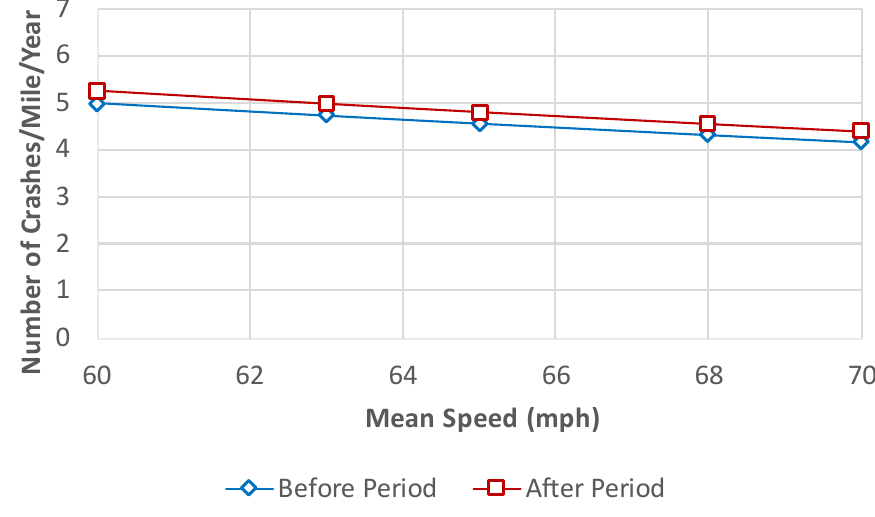
Figure 2 Annual number of crashes for increase sites based on mean